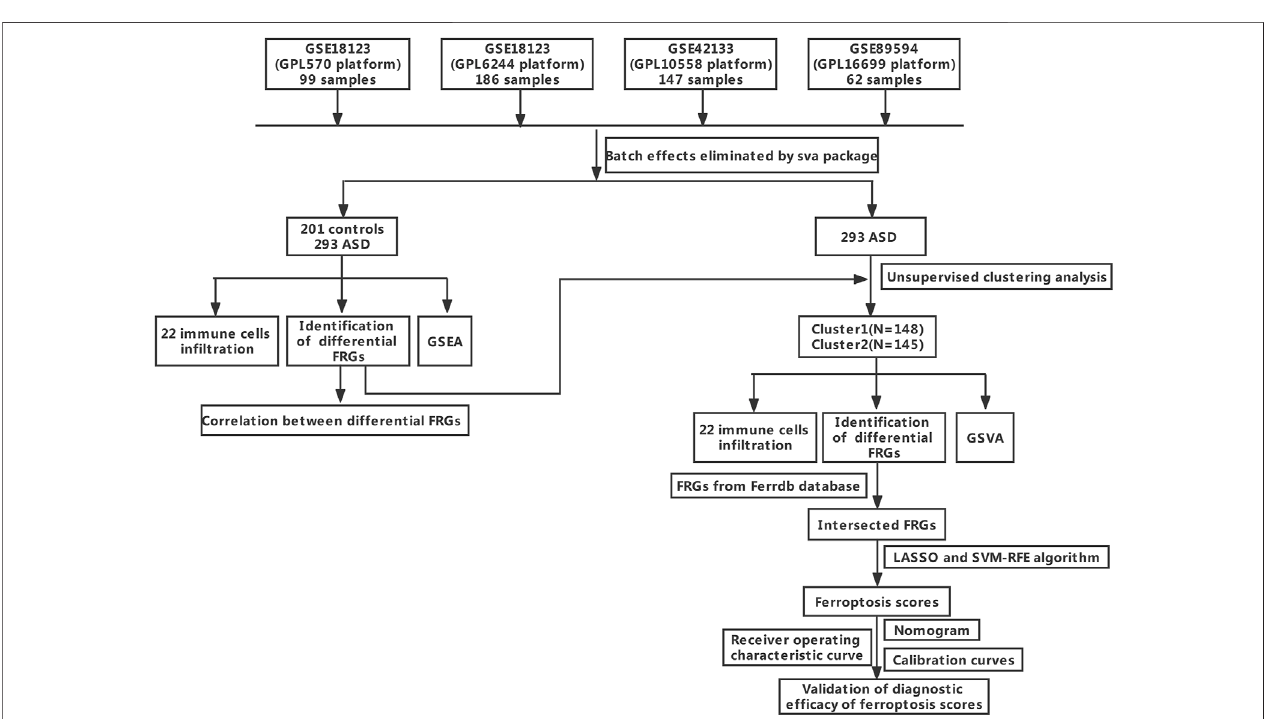
FIGURE 1 | The study fl ow